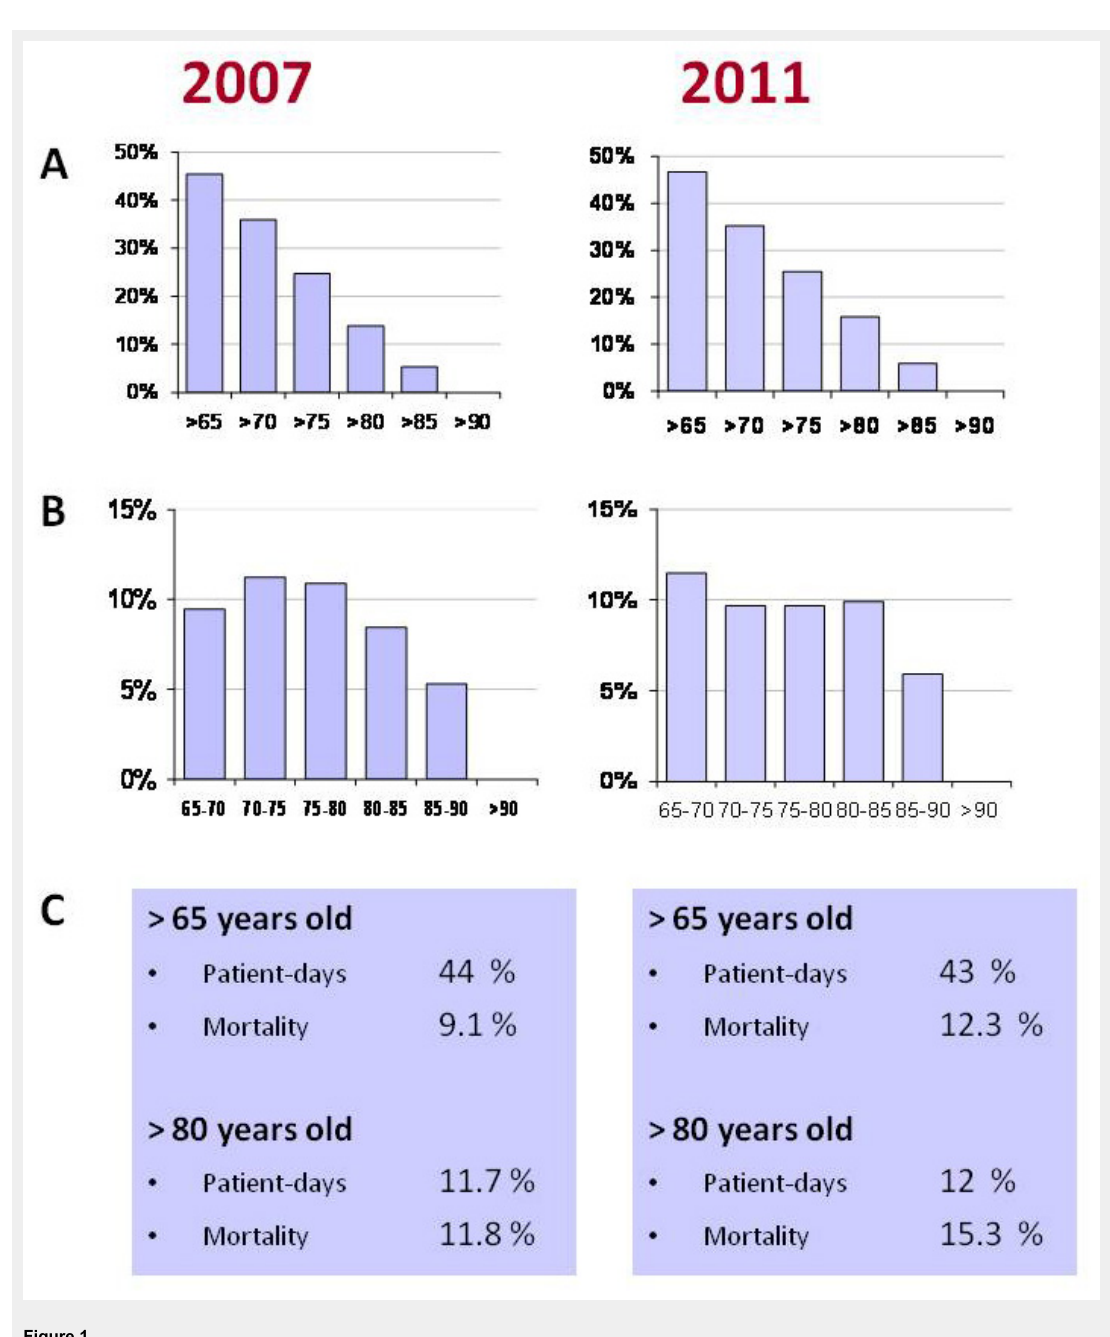
Figure 1 Evolution of the elderly population at Geneva ICU in 2007 compared to 2011. A Percentages of patients of more than 65, 70, 75, 80, 85 and 90 years of age. B Distribution by section of 5 years shows a trend towards more patients above 80 years in 2011. C The consumption expressed as patients-days remains stable. The mortality remains stable,